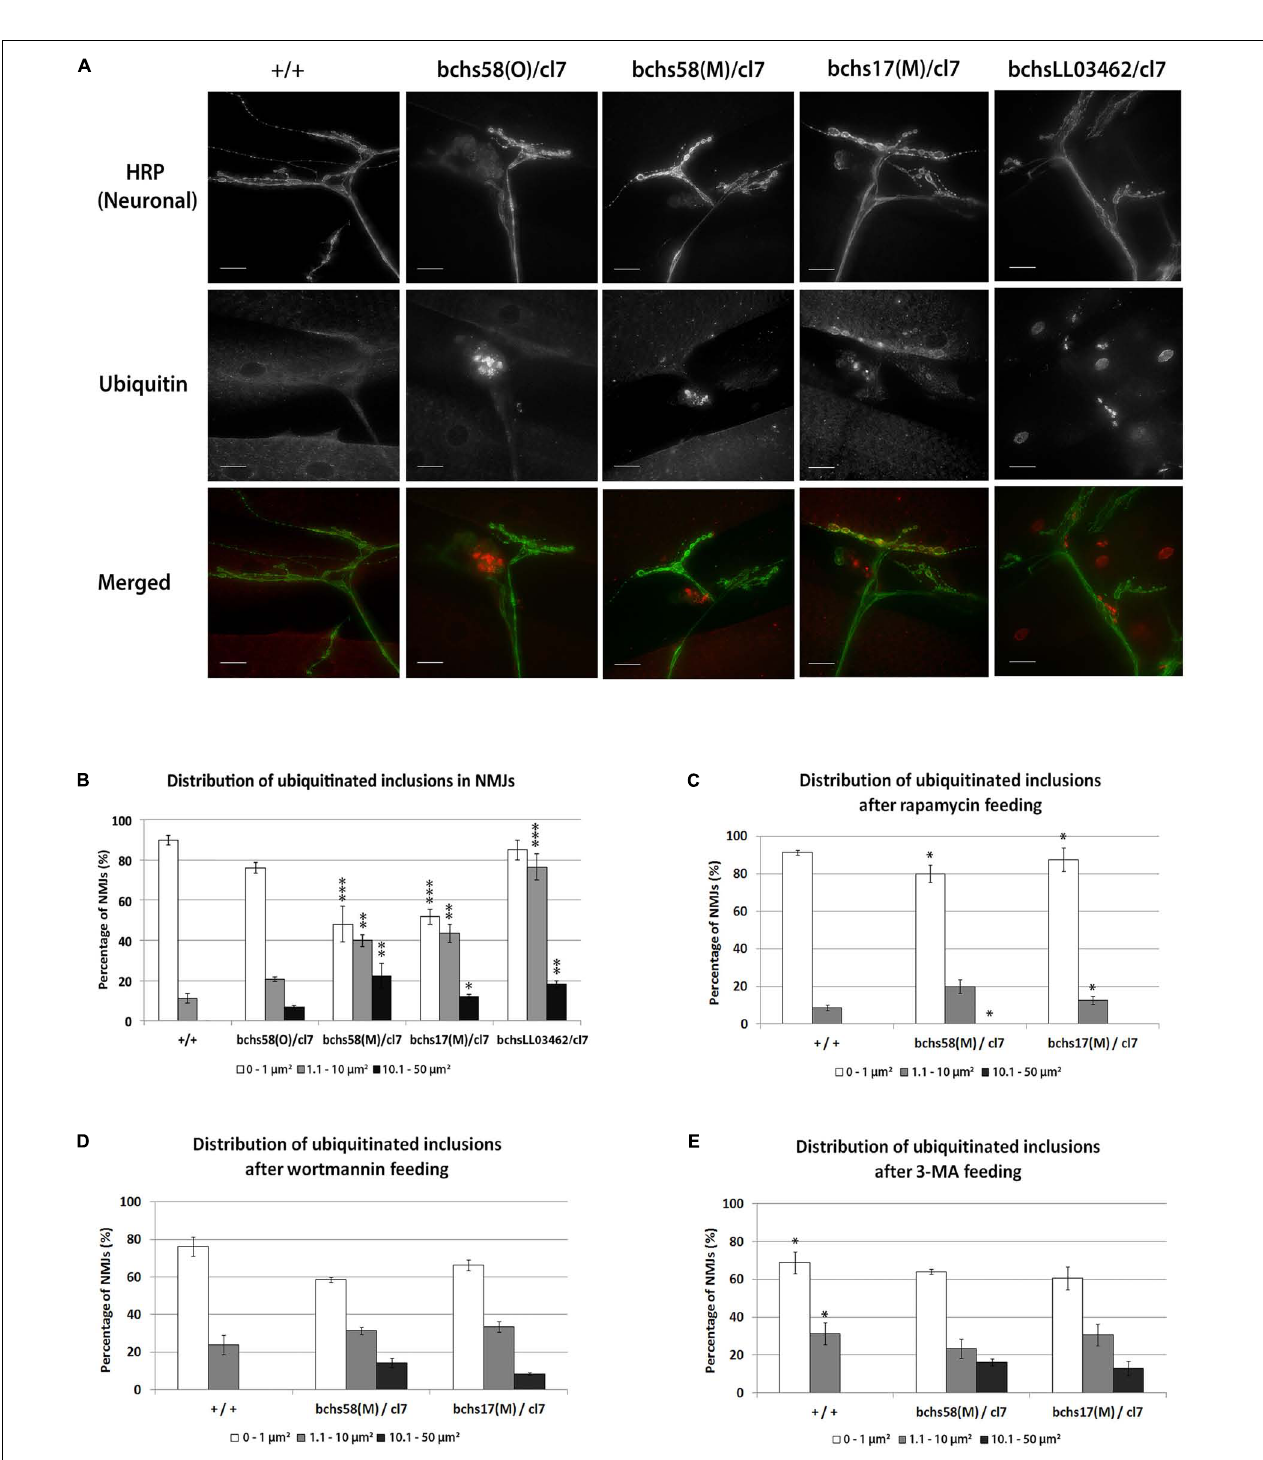
FIGURE 3 | Ubiquitinated aggregates accumulate in neuronal termini of bchs larval neuromuscular junctions and can be reduced by rapamycin feeding. (A) Third instar larvae were dissected and immunostained for anti-HRP (a pan-neuronal marker) and anti-poly-ubiquitin. Scale-bar = 20 µ m. (B) Percentages of neuromuscular junctions with ubiquitinated inclusions in each of three size groups (see Materials and Methods) were calculated for the different genotypes. Experiments were performed in duplicate, and error bars represent S.E.M. Chi-square test was used to determine pairwise statistical significance between frequency of occurrence of a given aggregate class in bchs vs. the same class in the wild-type control. ∗ p < 0.05, ∗∗ p < 0.01, ∗∗∗ p < 0.001. Larvae of the indicated genotypes were fed on (C) rapamycin, (D) Wortmannin, or (E) 3-methyladenine (see Materials and Methods) before repeating the same procedures as in (B) for analysis. Stars in (A) show significance of differences between classes in each of the genotypes and wild-type ( + / + ). Stars in (C) and (E) show significance for pairwise comparisons of numbers of ubiquitinated inclusions in the same genotype in (B) without drug.